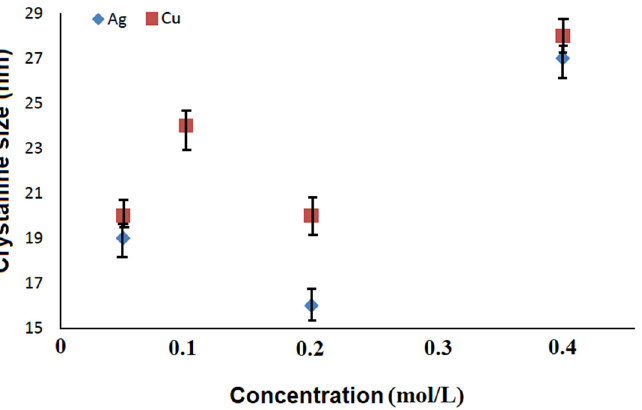
Figure 5. Relationship between concentration and crystalline size (800 °C, 1.0 L/min H 2 flow rate and 1.3 MHz).